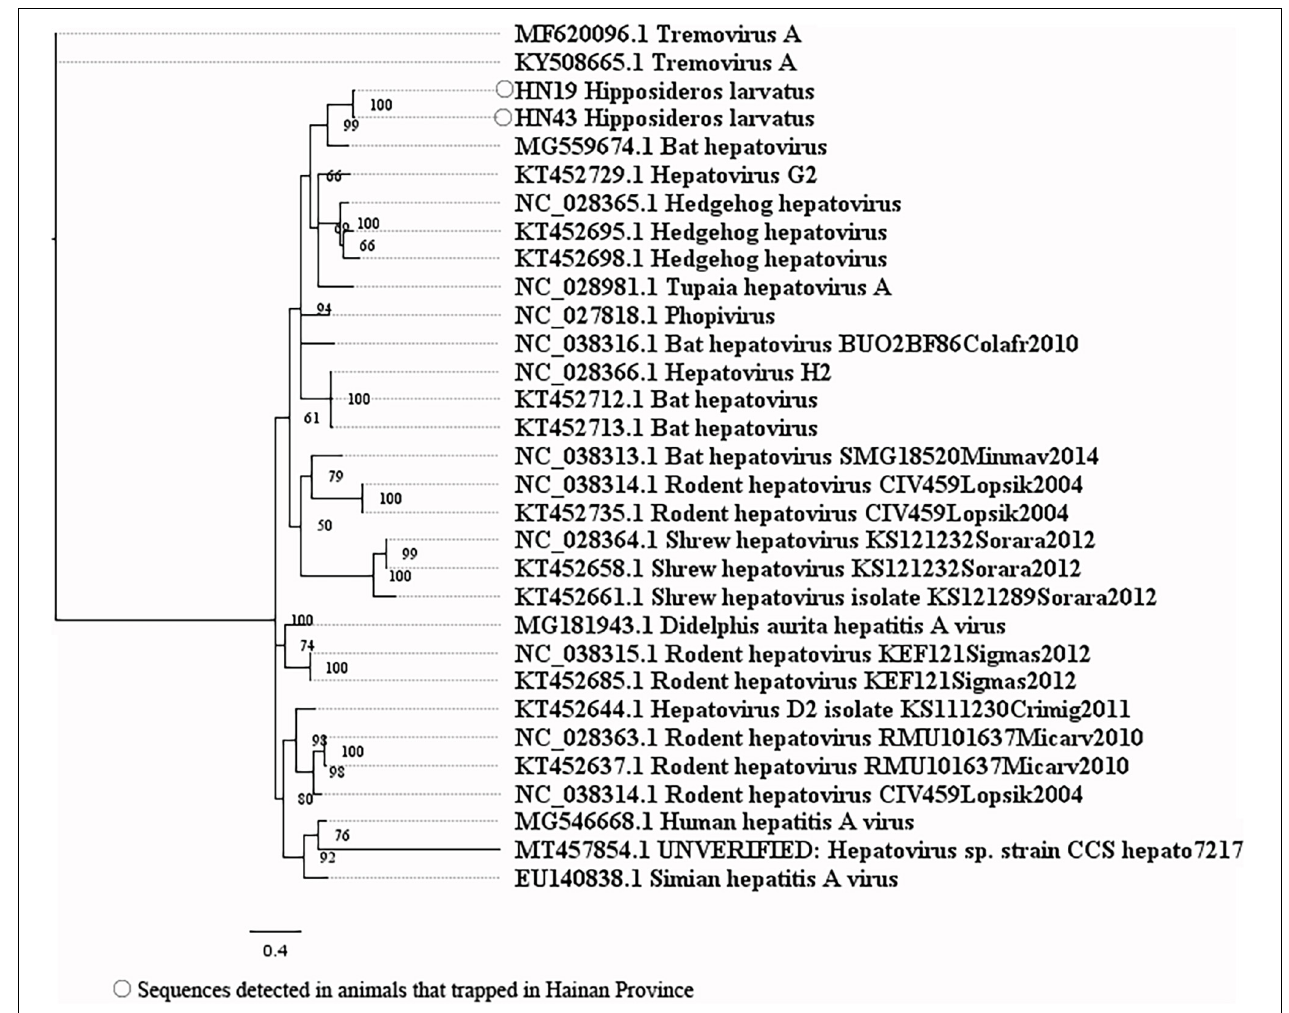
FIGURE 4 | Phylogenetic tree constructed based on PCR-screened nucleotide sequences (333 bp) of hepatovirus from bats (MrBayes, GTR + G + I nucleotide substitution model). A total of 27 representative hepatovirus sequences (polyprotein gene region) belonging to different species within genus Hepatovirus are included for comparison. Two tremovirus sequences are set as outgroup. Percentages of the posterior probability (PP) values are